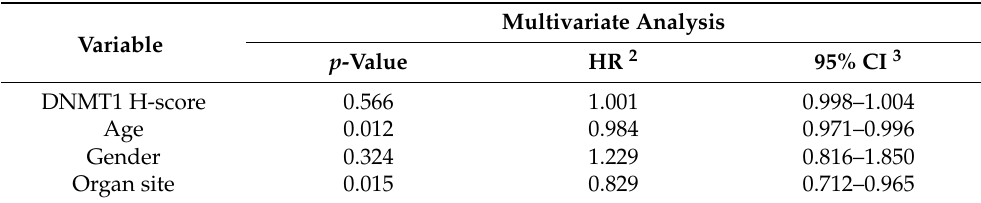
Table 2. Multivariate analyses including DNMT1 protein level for 4-year MSS 1 in stage IV melan- oma patients.